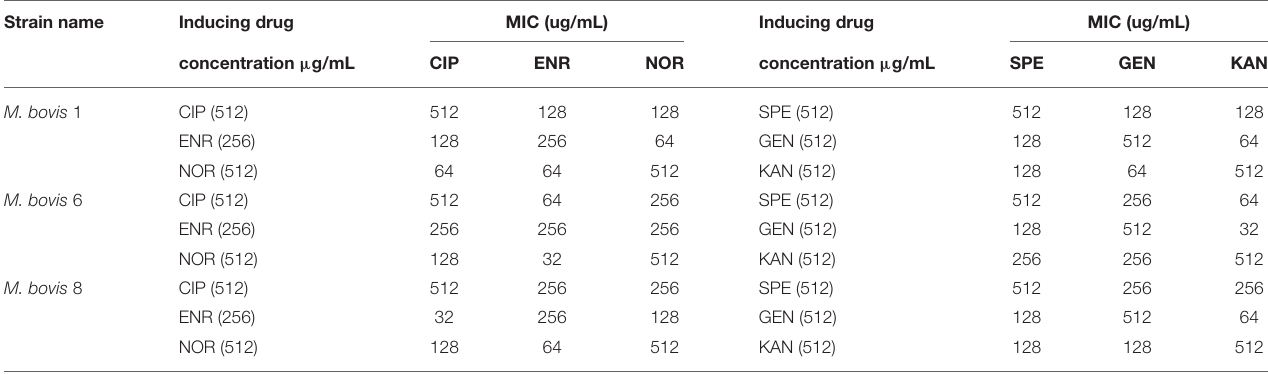
TABLE 3 | Test results of cross-resistance induced in vitro (ug/mL).